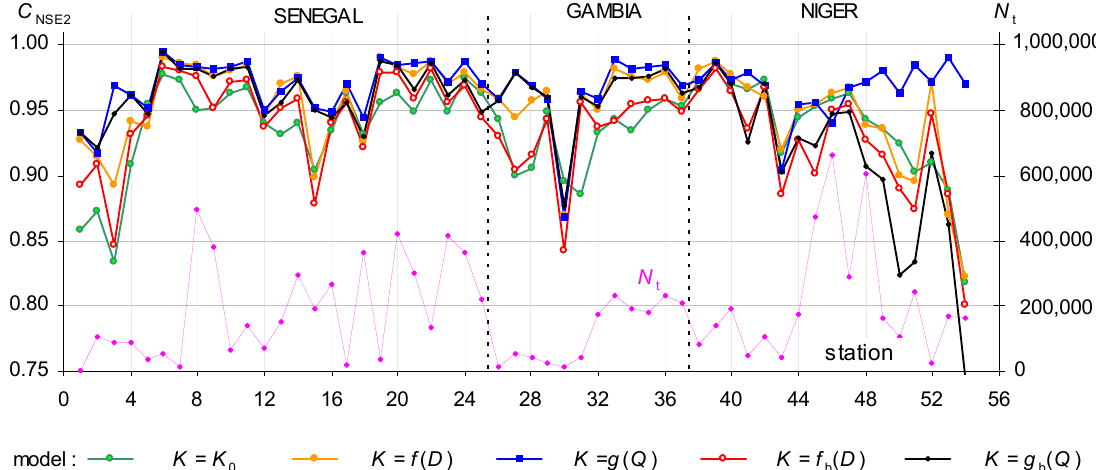
Figure 10. C NSE2 efficiency coefficient and number N t of the discharge forecasts made with the different K models (optimal K 0 value or D or Q functions) at all H horizons between 1 and 120 days.